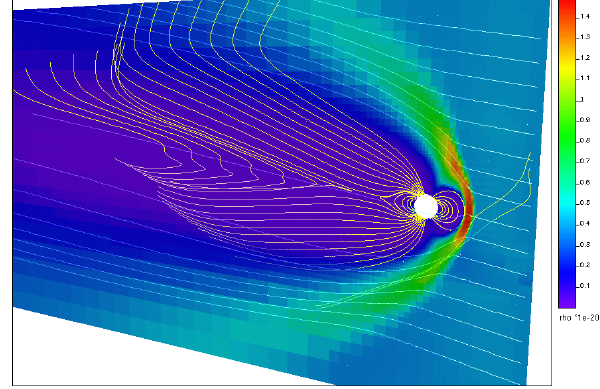
Fig. 1. The magnetosphere as rendered by Gumics-4. Colour cod- ing on the yz-plane depicts plasma density; yellow lines are mag- netic field lines and blue ones plasma flow lines. Behaviour of the grid can also be seen on the coloured